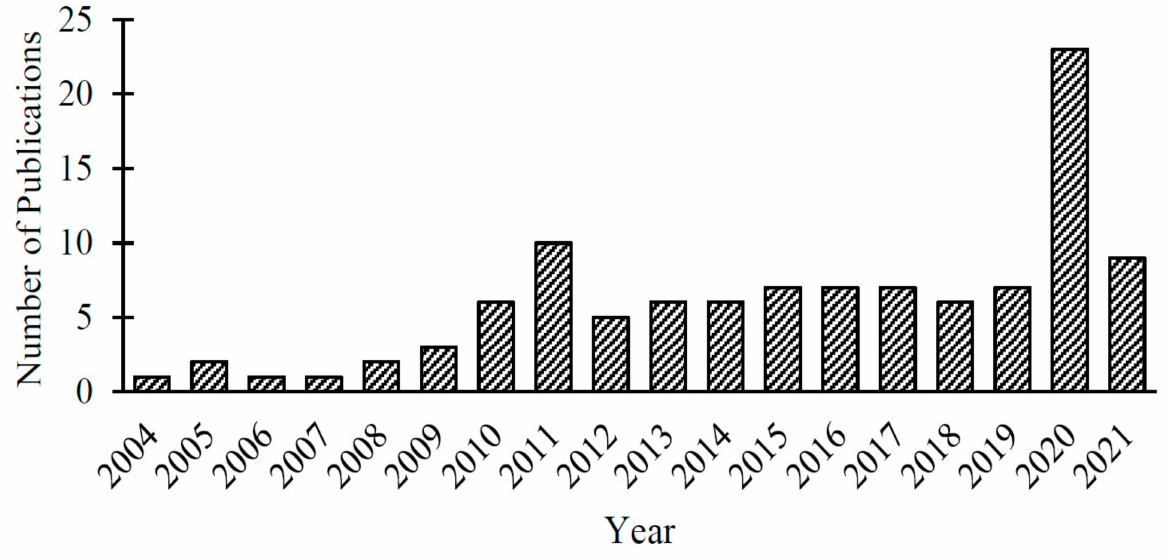
Figure 10. The trend of publications used ML for blasting-induced events prediction from 2004 to early 2021 [127]. Table 8 summarizes the recent research articles published to investigate blast-induced rock fragmentation using ANN. Moreover, it illustrates the study area, datasets, input parameters, architecture, and the developed model’s performance. Table 8. Summary of previous studies investigated blast-induced rock fragmentation using ANN in the last